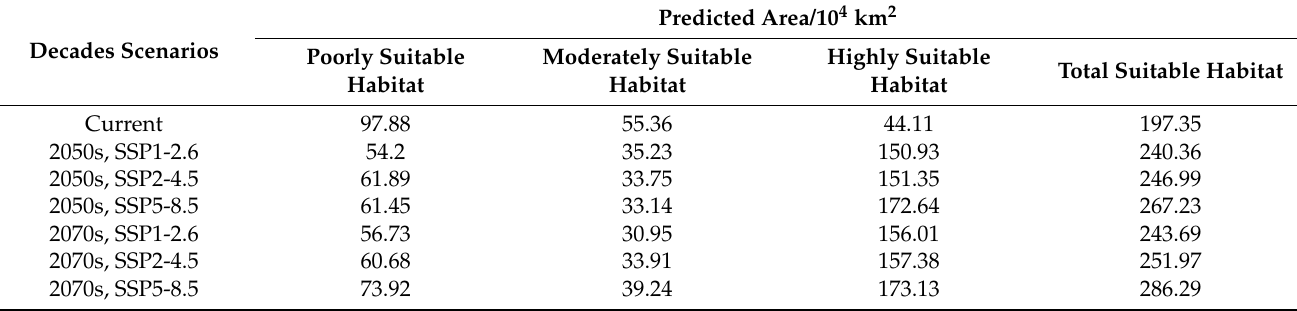
Table 3. Suitable areas for pine wilt disease under various climatic